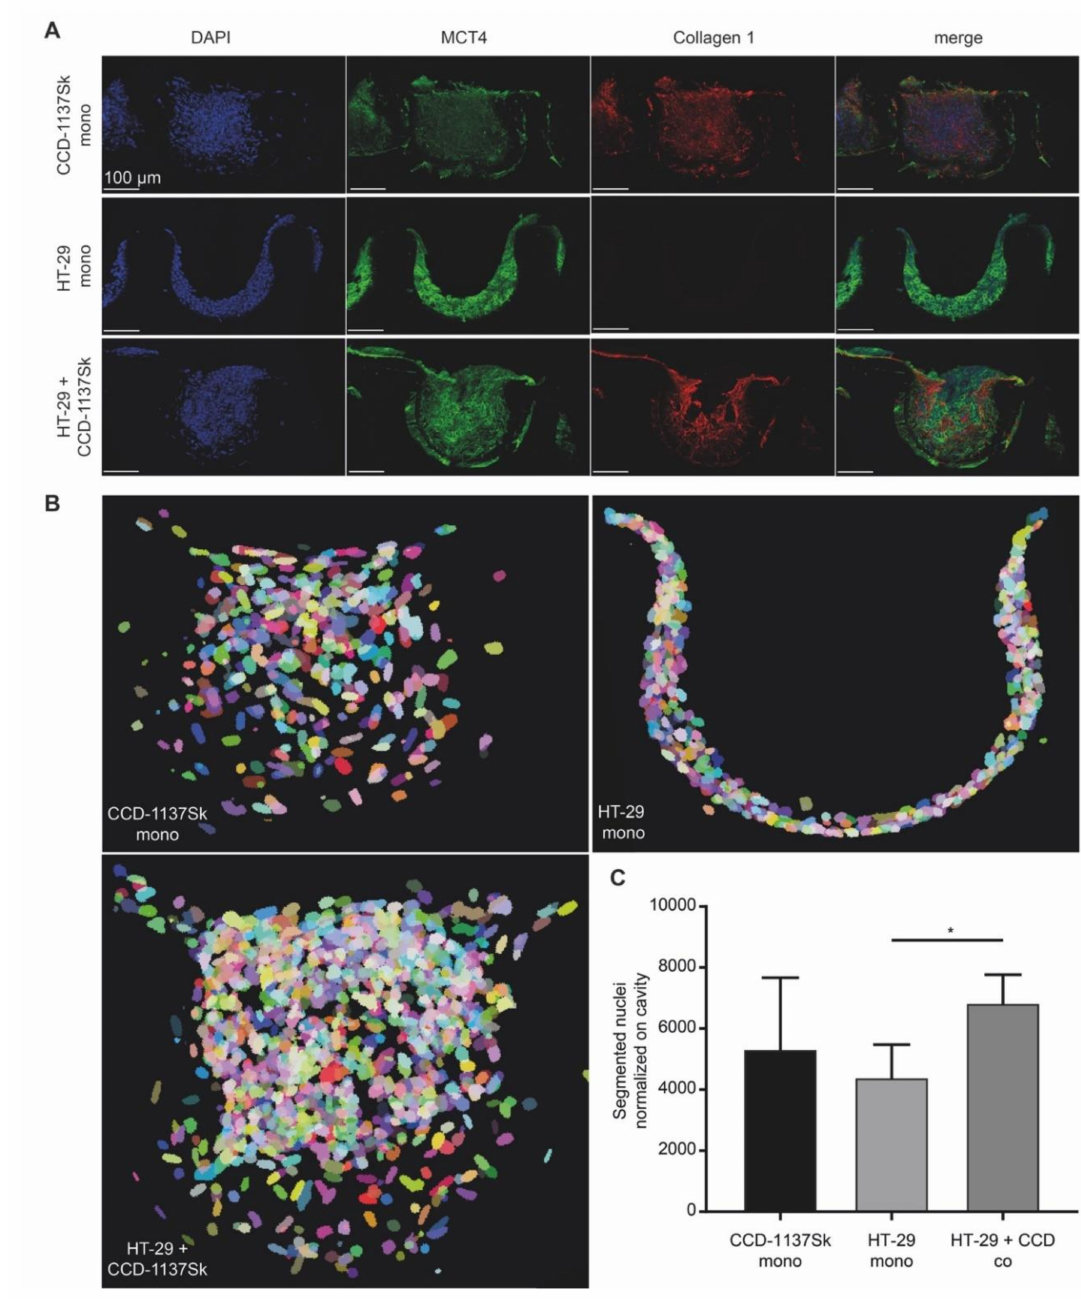
Figure 5. Chip-based 3-D cultures reveal morphological and metabolic changes upon co-cultivation of HT-29 and CCD-1137Sk cells. A total of 4000 cells per chip cavity were seeded to yield either mono- or co-cultures of HT-29 and CCD-1137Sk cells. In the case of co-cultures, 2000 HT-29 cells were co-seeded with 2000 CCD-1137Sk cells per well. After four days, chips were fixed, transversally sectioned, and then stained with DAPI as well as antibodies against MCT4 and collagen 1 as markers for nuclei, lactate export, and extracellular matrix (ECM), respectively. Subsequently, sections were imaged with confocal microscopy. ( A ) Representative maximum-z projections. ( B ) Representative display of segmented nuclei from di ff erent culture conditions as indicated. Pseudo-colors were chosen to discriminate between individual nuclei. They do not indicate di ff erent cell types. ( C ) Quantitative analysis of nuclear counts. Mean + SEM ( n = 3